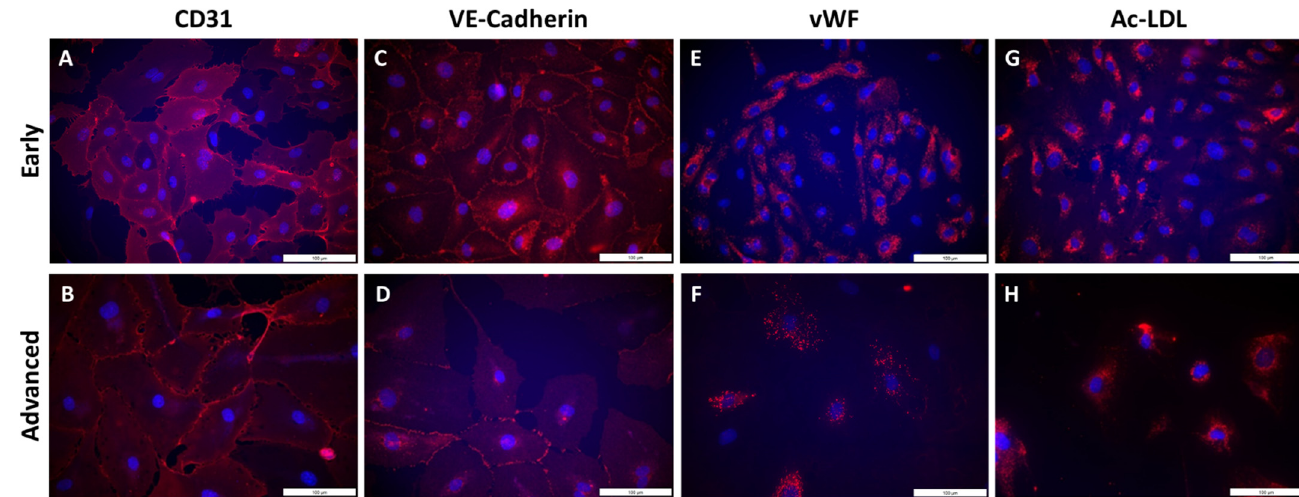
Figure 5. Qualitative phenotyping of PAECs using endothelial-specific markers in early and advanced subcultures. Staining of endothelial surface markers CD31 ( A , B ) and VE-Cadherin ( C , D ), endothelial intracellular markers von Willebrand factor (vWF; E , F ) and Ac-LDL uptake ( G , H ) was performed by immunofluorescence in early ( A , C , E , G ) and advanced subcultures ( B , D , F , H ). Nuclei were counterstained using DAPI (blue). Scale = 100 µm.